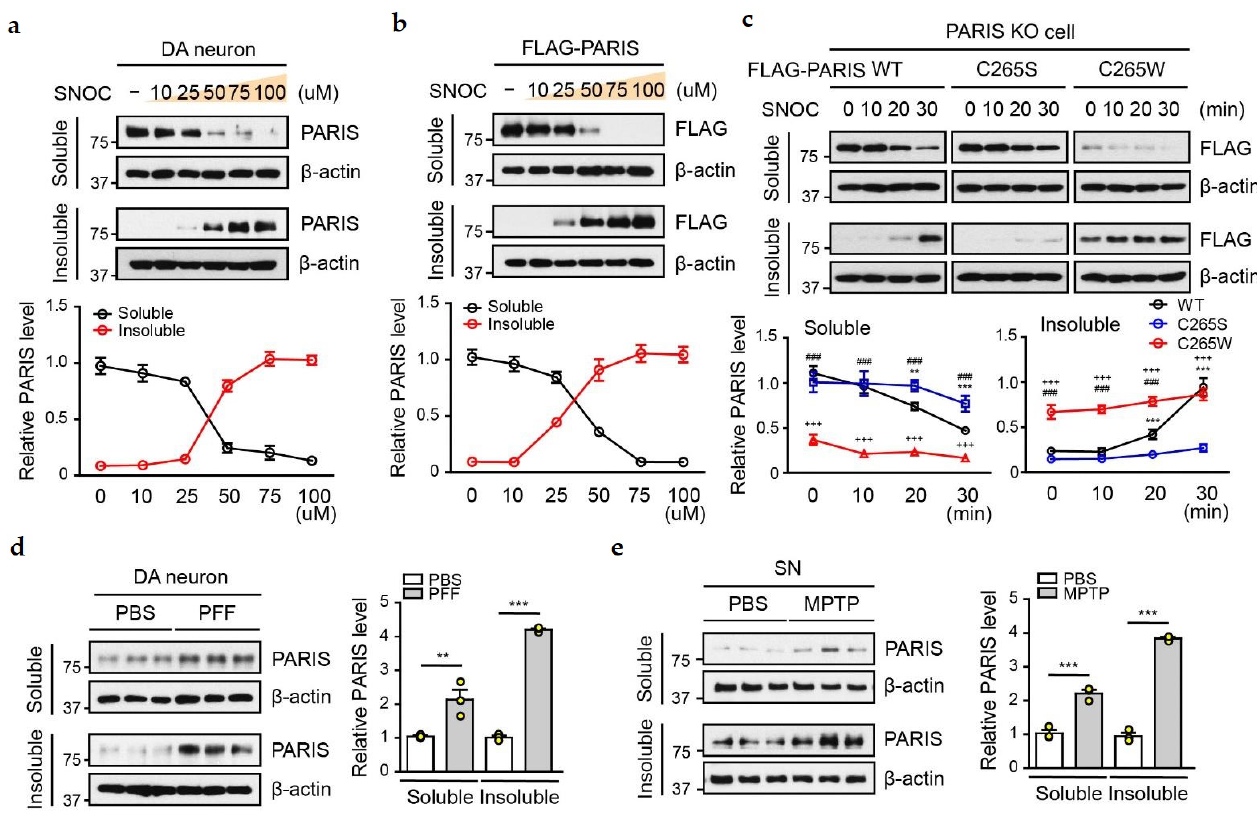
Figure 3. S-nitrosylated PARIS translocates to the insoluble fraction. ( a ) PARIS translocation to the insoluble fraction by SNOC. Cell lysates from primary DA neurons were exposed to different concentrations of SNOC (0–100 µ M) for 30 min and then separated into RIPA-soluble and RIPA- insoluble fractions. Bottom panel, relative PARIS levels normalized to β -actin, n = 3. ( b ) Lysates from SH-SY5Y cells expressing FLAG-tagged PARIS were exposed to different concentrations of SNOC (0–100 µ M) for 30 min and then separated into RIPA soluble and RIPA insoluble fractions. Bottom panel, relative PARIS levels normalized to β -actin, n = 3. ( c ) Representative immunoblots showing time-dependent alteration in PARIS solubility. SH-SY5Y PARIS KO cells expressing FLAG-PARIS WT, S-nitrosylation deficient mutant (C265S) and mimic mutant (C265W) were exposed to SNOC (50 µ M) for the indicated time (0–30 min), and their lysates were then divided into RIPA-soluble and RIPA-insoluble fractions. PARIS levels in the soluble (left bottom panel) and insoluble fractions (right bottom panel) normalized to β -actin ( n = 3). Two-way ANOVA was followed by Bonferroni’s post-test, WT vs. C265S; ** p < 0.01, *** p < 0.001, WT vs. C265W; ### p < 0.001, C265S vs. C265W; +++ p < 0.001. ( d ) Cell lysates from primary DA neurons were treated with α -syn PFFs (0.1 mg/mL α -syn PFFs diluted in media with a ratio of 1:25) for 2 weeks and then separated into RIPA-soluble and RIPA-insoluble fractions. PARIS was detected using the anti-PARIS antibody. Right panel—relative PARIS levels normalized to β -actin, n = 3, one-way ANOVA followed by Tukey’s multiple comparison test, ** p < 0.01, *** p < 0.001. ( e ) Lysates from the SN region of PBS- and MPTP-administered mice were separated into RIPA soluble and RIPA insoluble fractions, followed by immunoblot assay with anti-PARIS antibody. Right panel—relative PARIS level normalized to β -actin, n = 3. One-way ANOVA followed by Tukey’s multiple comparison test, *** p <